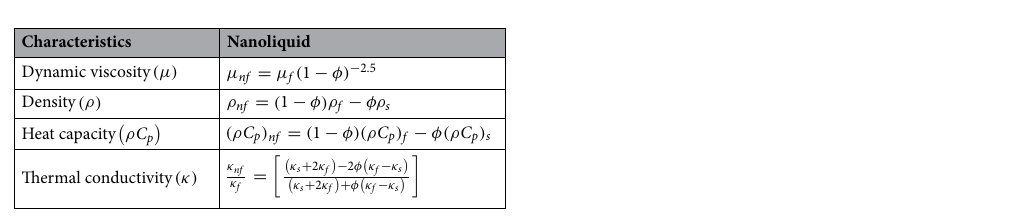
Figure 3. Flow model discription.